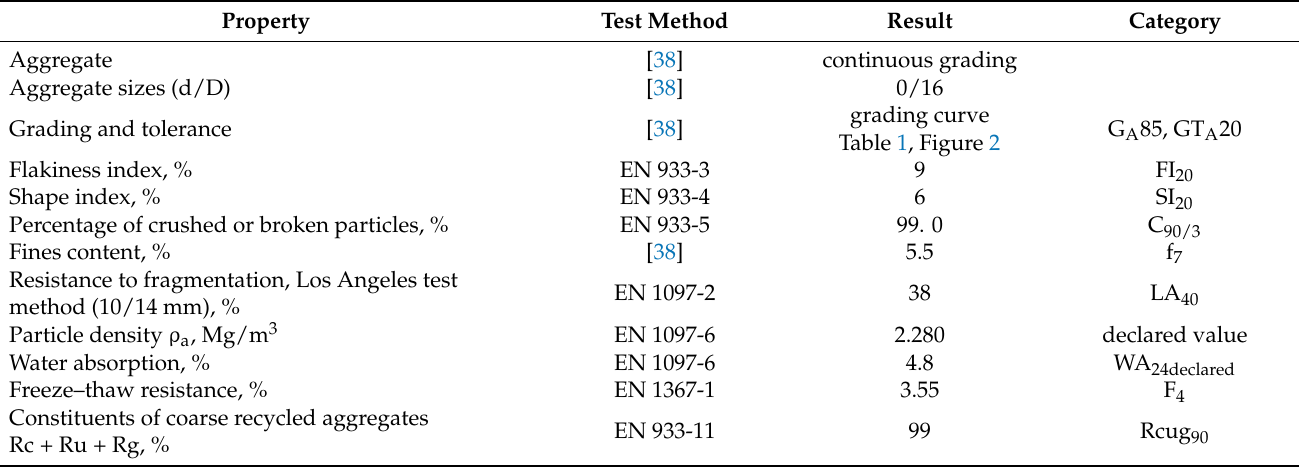
Table 2. Geometric and physical properties of reclaimed cement material (RCM) acc. EN